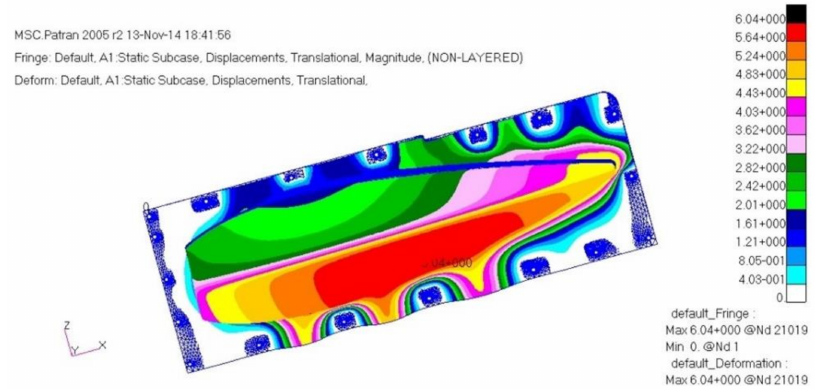
Figure 15. Displacement analysis